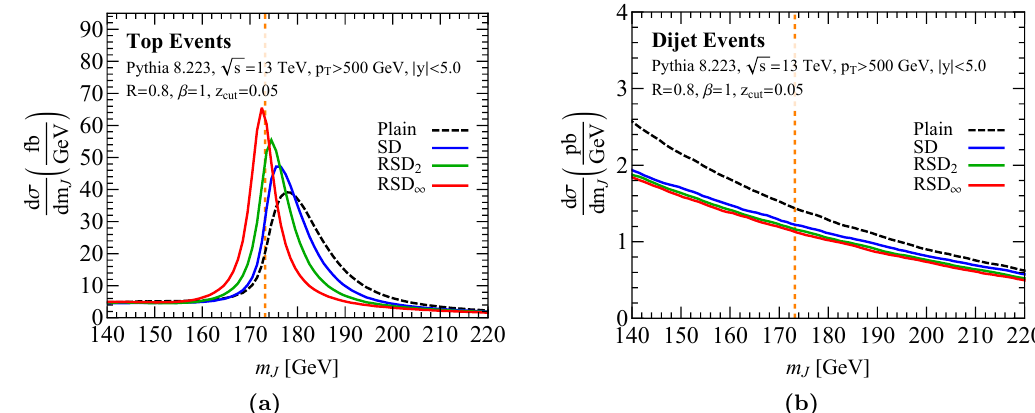
Figure 1. Behavior of RSD in (a) boosted top signals and (b) corresponding dijet backgrounds, using Pythia 8 .223 and R = 0 : 8 anti- k t jets. The benchmark SD condition in eq. (1.1) uses (cid:12) = 1 and z cut = 0 :